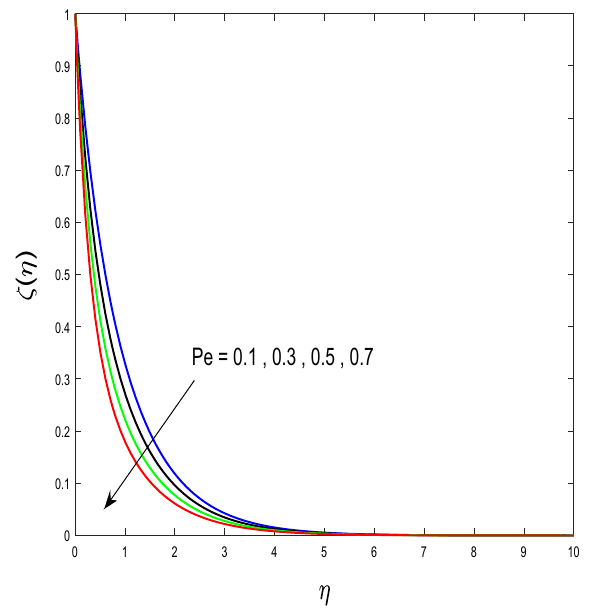
Figure 19. Plot of ξ for Pe .